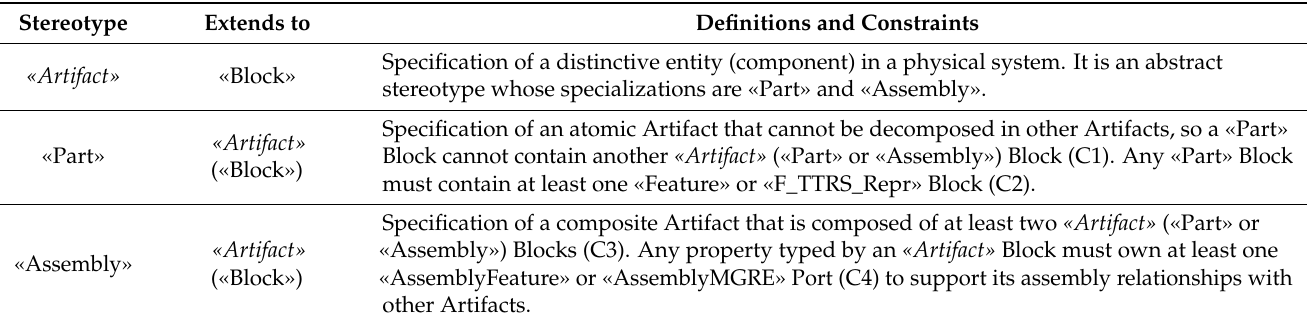
Table A1. Description of main ArtMPP stereotypes.